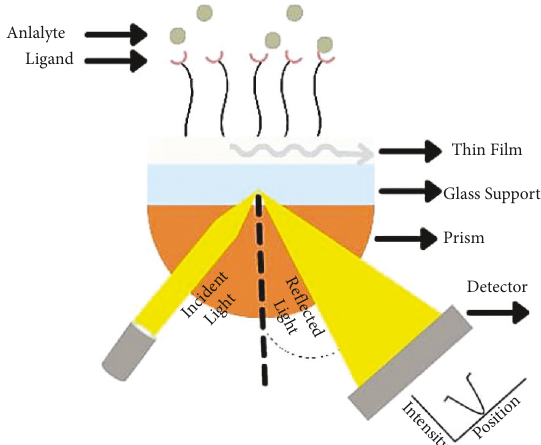
Figure 1: Illustration of surface plasmons resonance